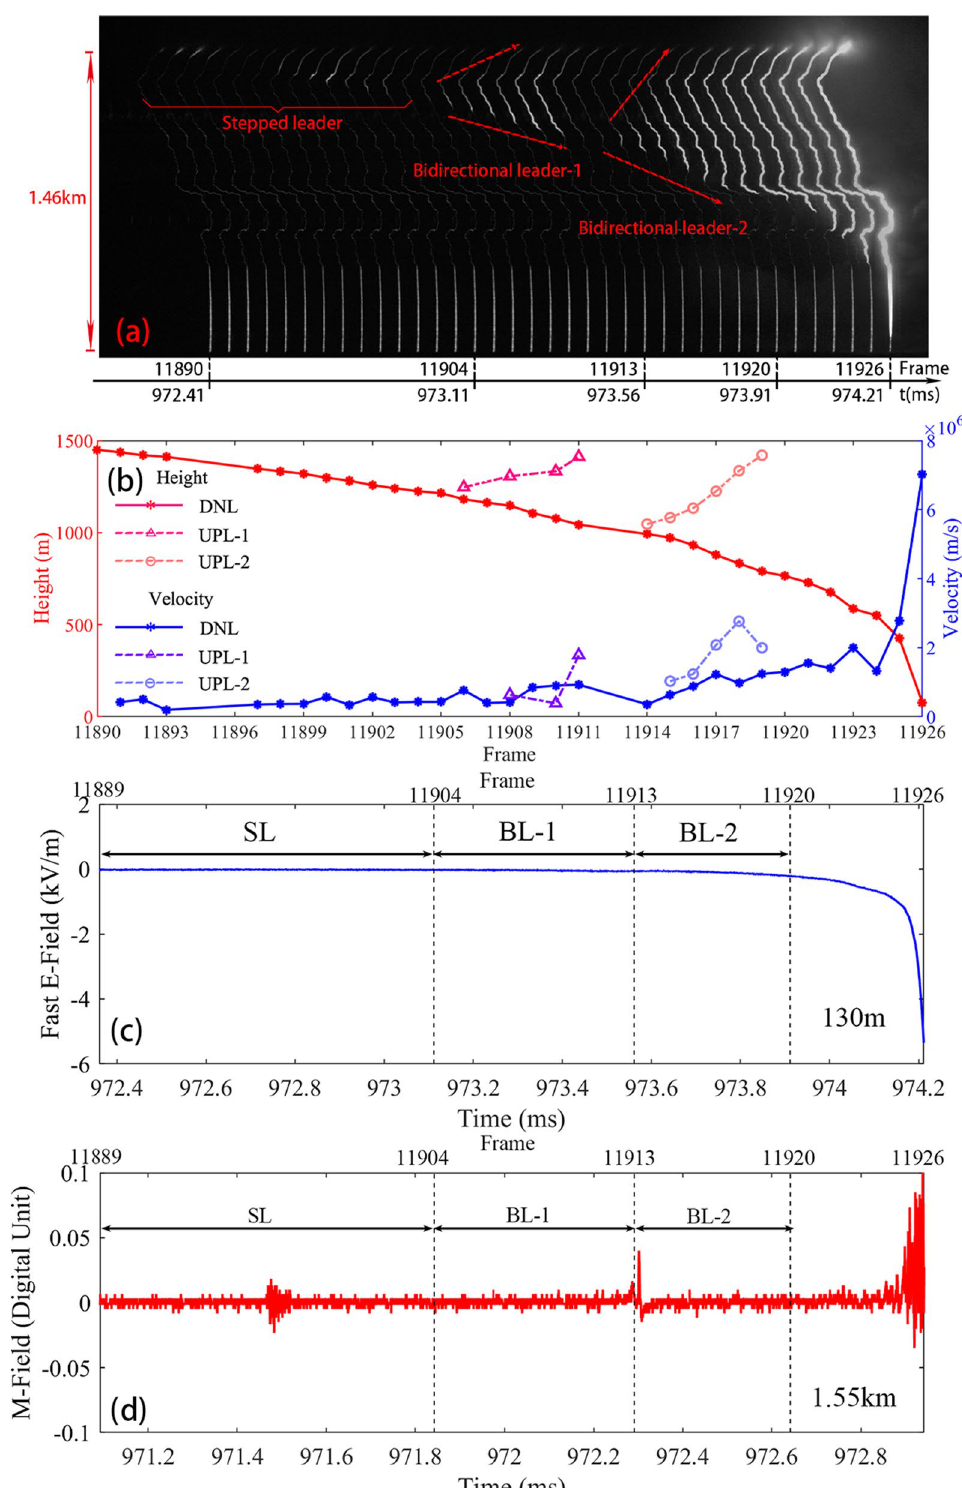
Figure 2. Overview of the leader process before the RS4. ( a ) Image with arranged consecutive high-speed video frames revealing the development of stepped leader and bidirectional leaders. The time interval between two consecutive frames was 50 μs (20,000 fps); ( b ) variations of the height and the 2-D estimated velocity of both upward positive leader (UPL) and downward negative leader (DNL); ( c ) electric field change 130 m away from the rocket launcher; ( d ) Magnetic field 1.55 km away from the rocket launcher; There was a delay of 1.27 ms between the waveforms measured at 130 m and 1.55 km respectively. The number of frames of several high- speed video corresponding to the waveform was marked on the top of the